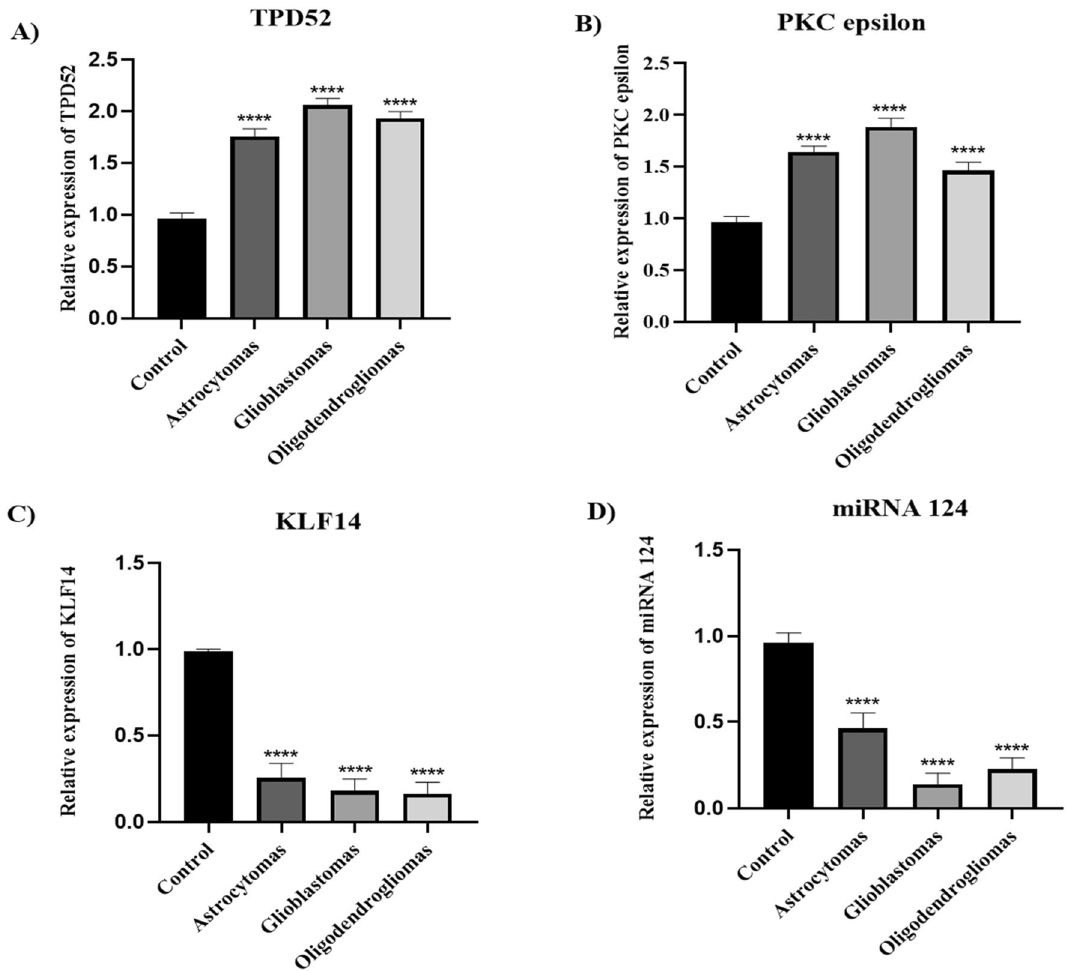
Figure 6. Expression of TPD52, PKCε, KLF14 and miRNA124 in brain tumor subtypes. ( A ) Expression of TPD52 in astrocytomas, glioblastomas, and oligodendrogliomas patients compared to healthy controls; ( B ) Expression of PKCε in astrocytomas, glioblastomas, and oligodendrogliomas patients compared to healthy controls; ( C ) Expression of KLF14 in astrocytomas, glioblastomas, and oligodendrogliomas patients compared to healthy controls; ( D ) Expression of miRNA 124 in astrocytomas, glioblastomas, and oligodendrogliomas patients compared to healthy controls . There is an elevated expression of TPD52 and PKCε in glioblastoma compared to astrocytomas and oligodendrogliomas. KLF14 expression was lower in glioblastomas, and oligodendrogliomas in comparison to astrocytomas. miRNA 124 expression was higher in astocytomas in comparison to glioblastomas, and oligodendrogliomas but lower compared to healthy control. Representative data were presented as mean ± SEM of triplicate experiments. Statistical significance was measured by one-way ANOVA (**** P <